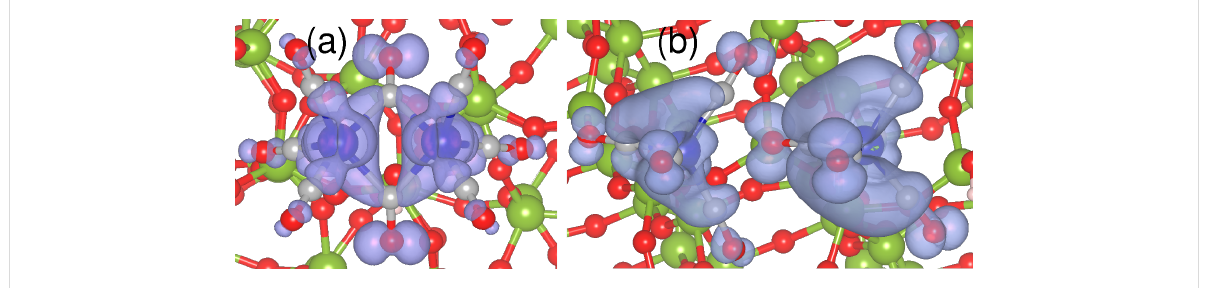
Figure 8: Band decomposed charge density for the valence band maximum for Co 2 (CO) 8 on the (a) FOH-SiO 2 and (b) POH-SiO 2 surfaces.